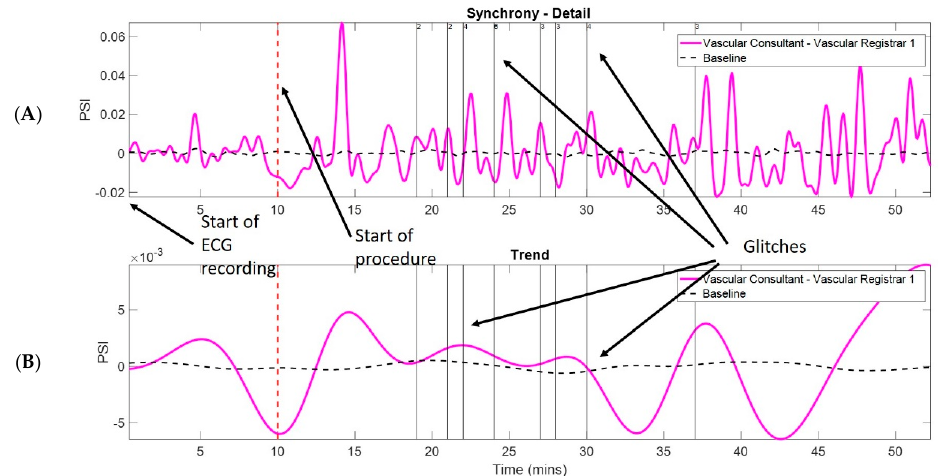
Figure 2. Heart rate variability (HRV) synchronies and synchrony trends within vascular pair in response to glitches from a representative case. Detailed HRV synchrony ( A ) and its trend ( B ) (magenta) are shown. Black dotted horizontal line shows baseline of HRV synchrony. Glitches are shown as vertical black solid lines with the number of a recorded glitch at the top (black arrows showing glitches). Red vertical dotted line shows the time of starting the procedure.